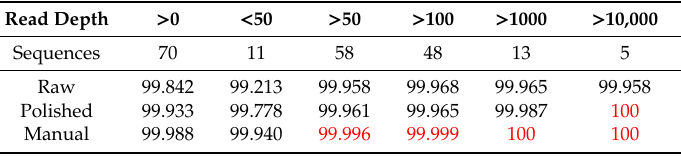
Table 4. Accuracy of consensus sequences generated from MinION sequencing data by three methods. Sequence accuracy of the raw consensus (Raw), consensus after polishing with raw reads using Nanopolish (Polished), and Nanopolished consensus after manual correction of indels in homopolymer regions (Manual) is shown relative to Sanger sequencing consensus. Sequence accuracy and number of sequences examined are shown for six di ff erent read depth levels. Accuracy above 99.99% is highlighted in red